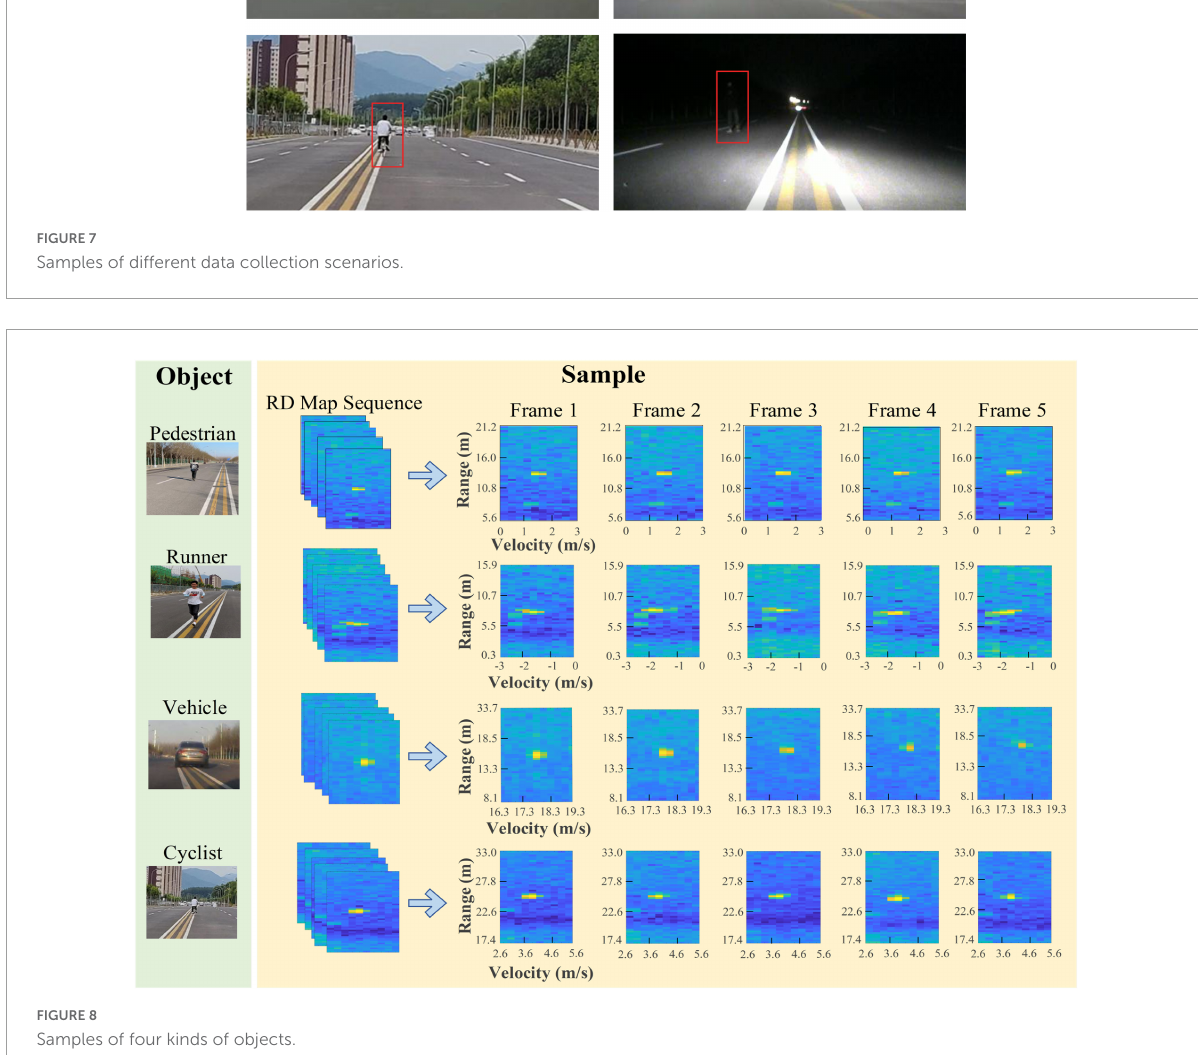
FIGURE8 Samples of four kinds of